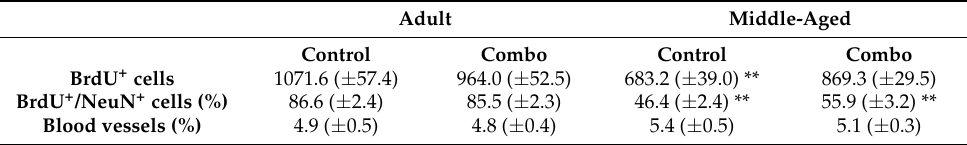
Table 1. Neurogenesis and angiogenesis in adult and middle-aged